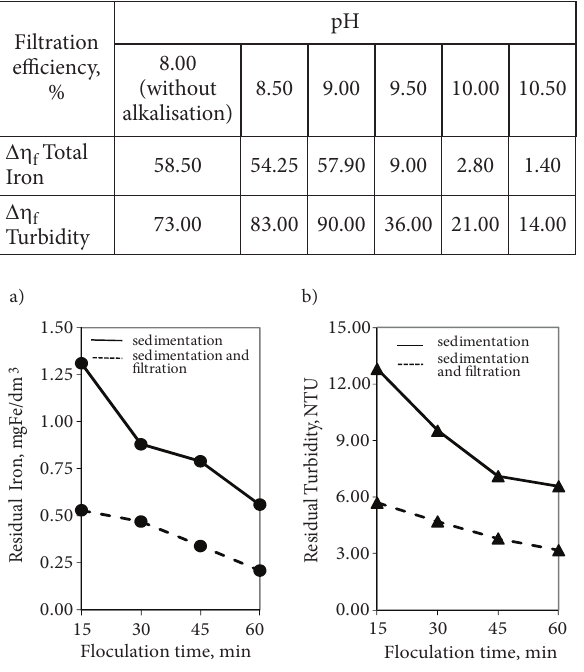
Figure 5. Influence of flocculation time on residual iron (a) and residual turbidity (b) in the water after the Ca(OH) 2 alkalinisation to pH = 10